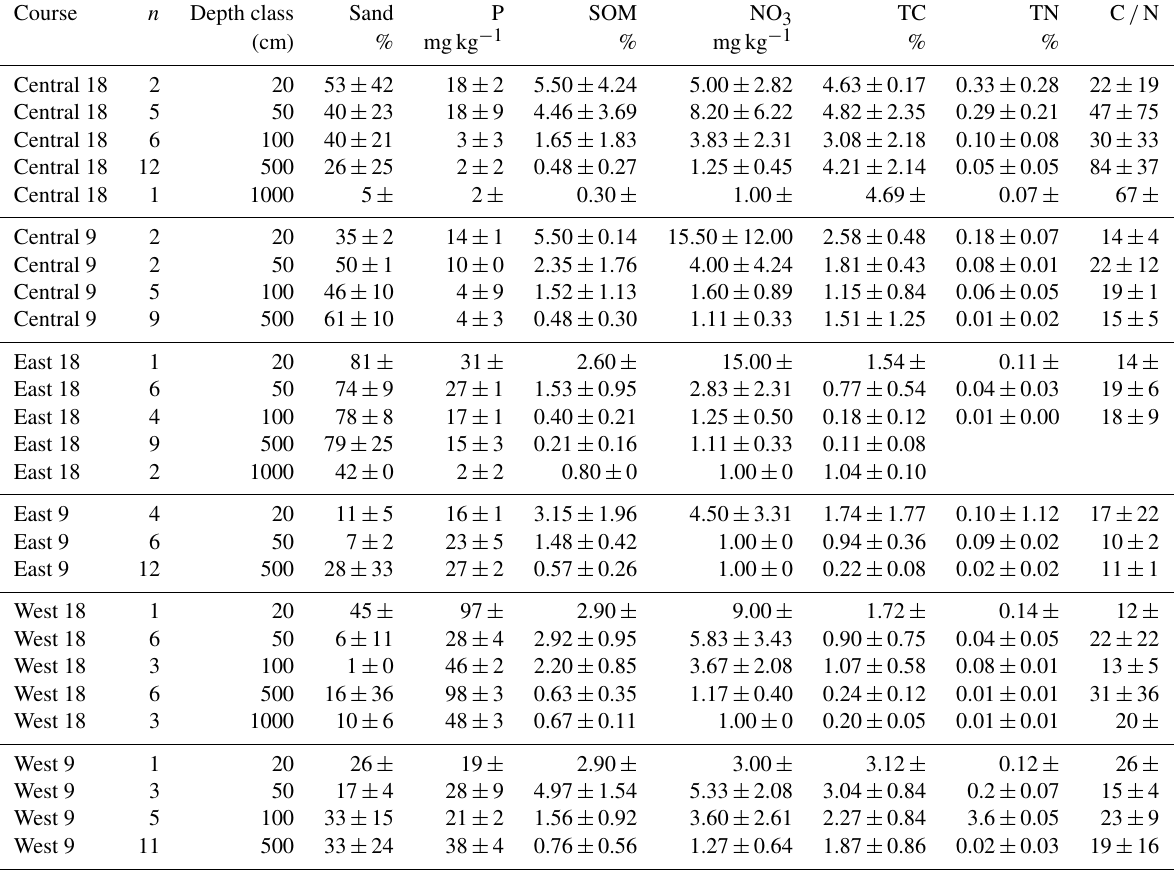
Table 3. Soil conditions (mean and standard deviation) by depth at Iowa golf courses.